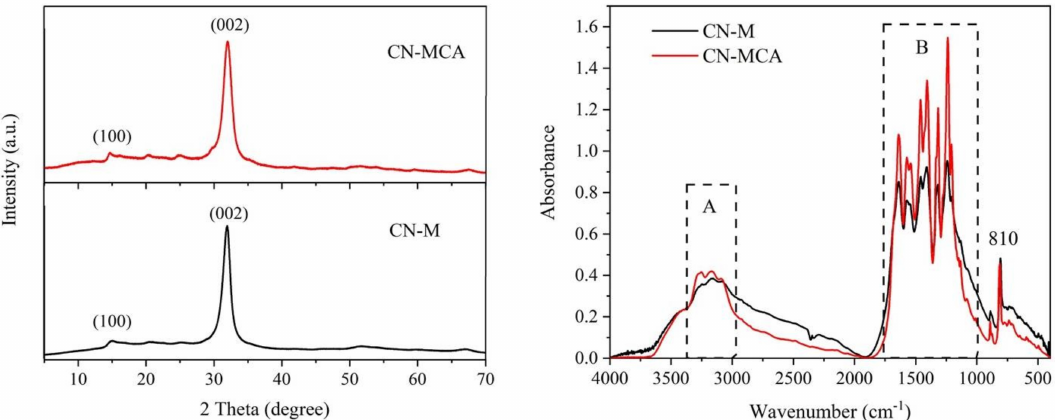
Figure 3. X-ray diffraction (XRD) patterns ( left ) and Fourier transform infrared (FTIR) spectra ( right ) of CN materials.